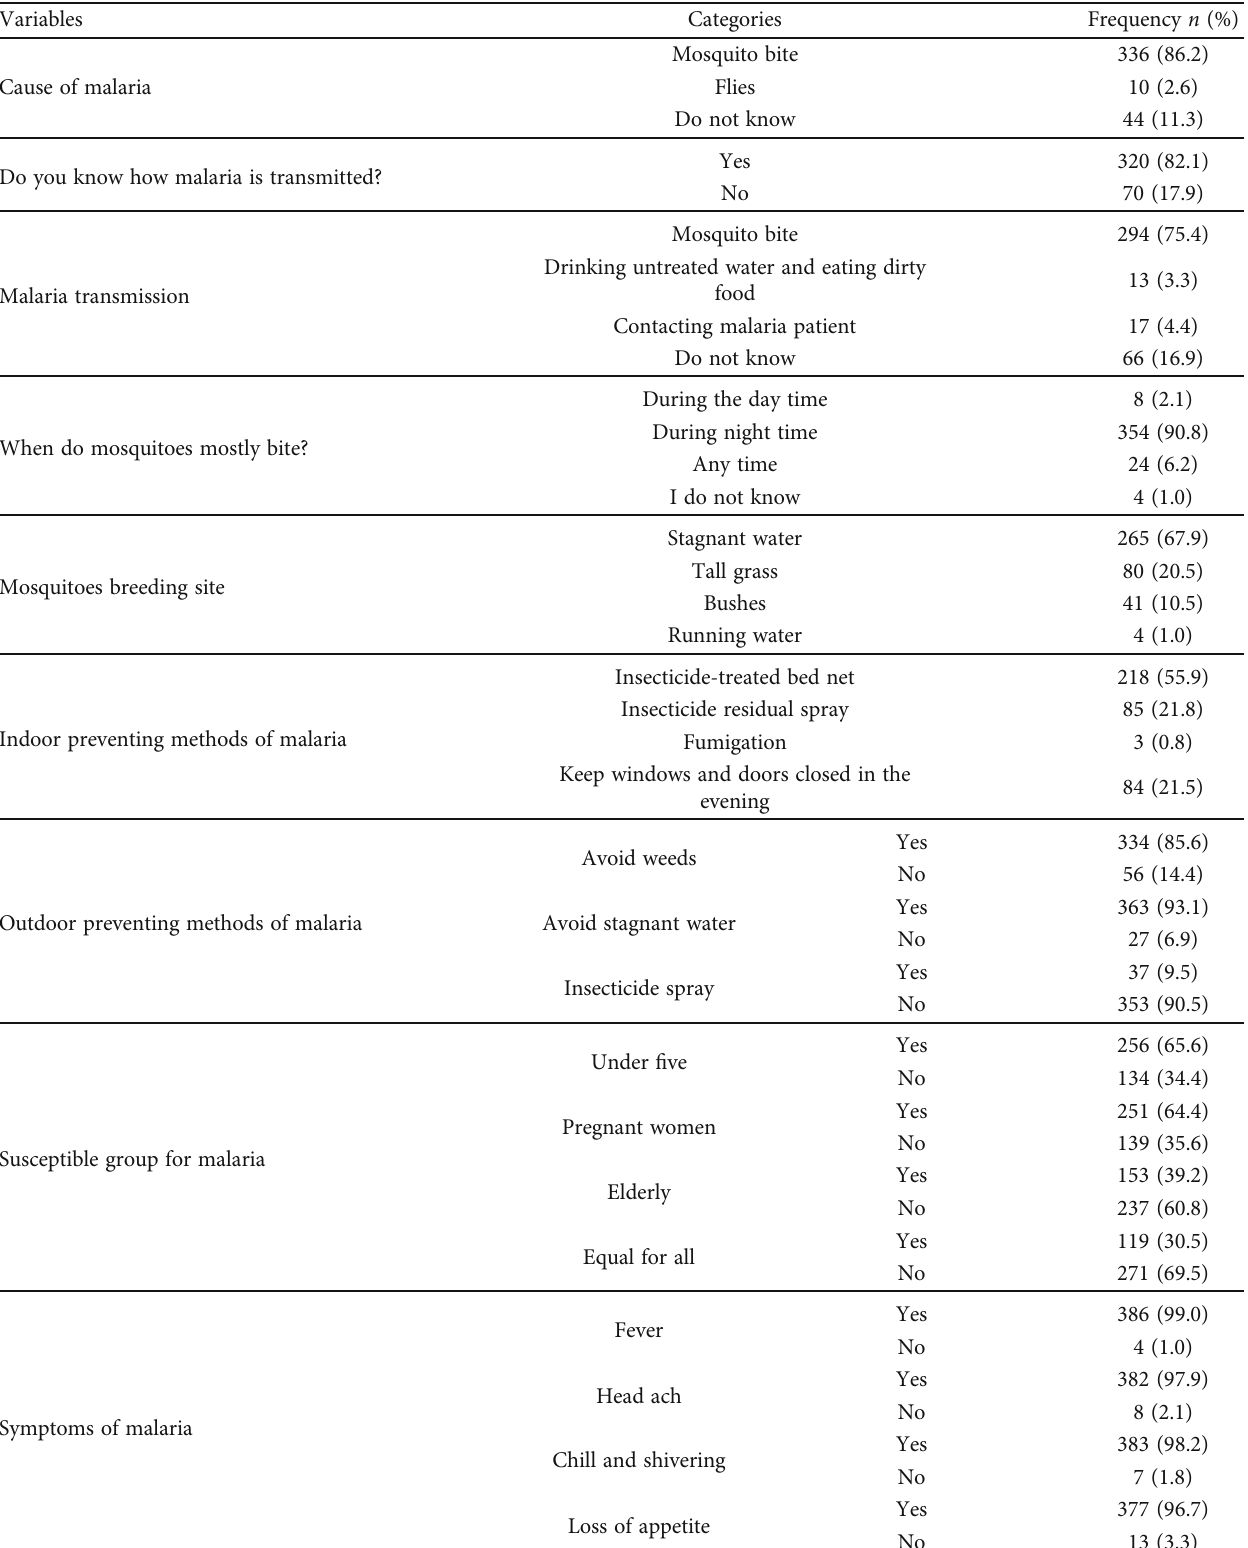
Table 2: Knowledge of respondents related to cause, sign and symptoms, transmission of malaria, and mosquito breeding areas, Mekaneeyesus hospital, South Gondar, northwestern Ethiopia,